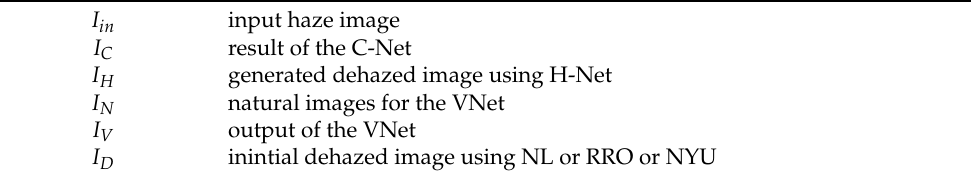
Table 1. Conventions of image types.